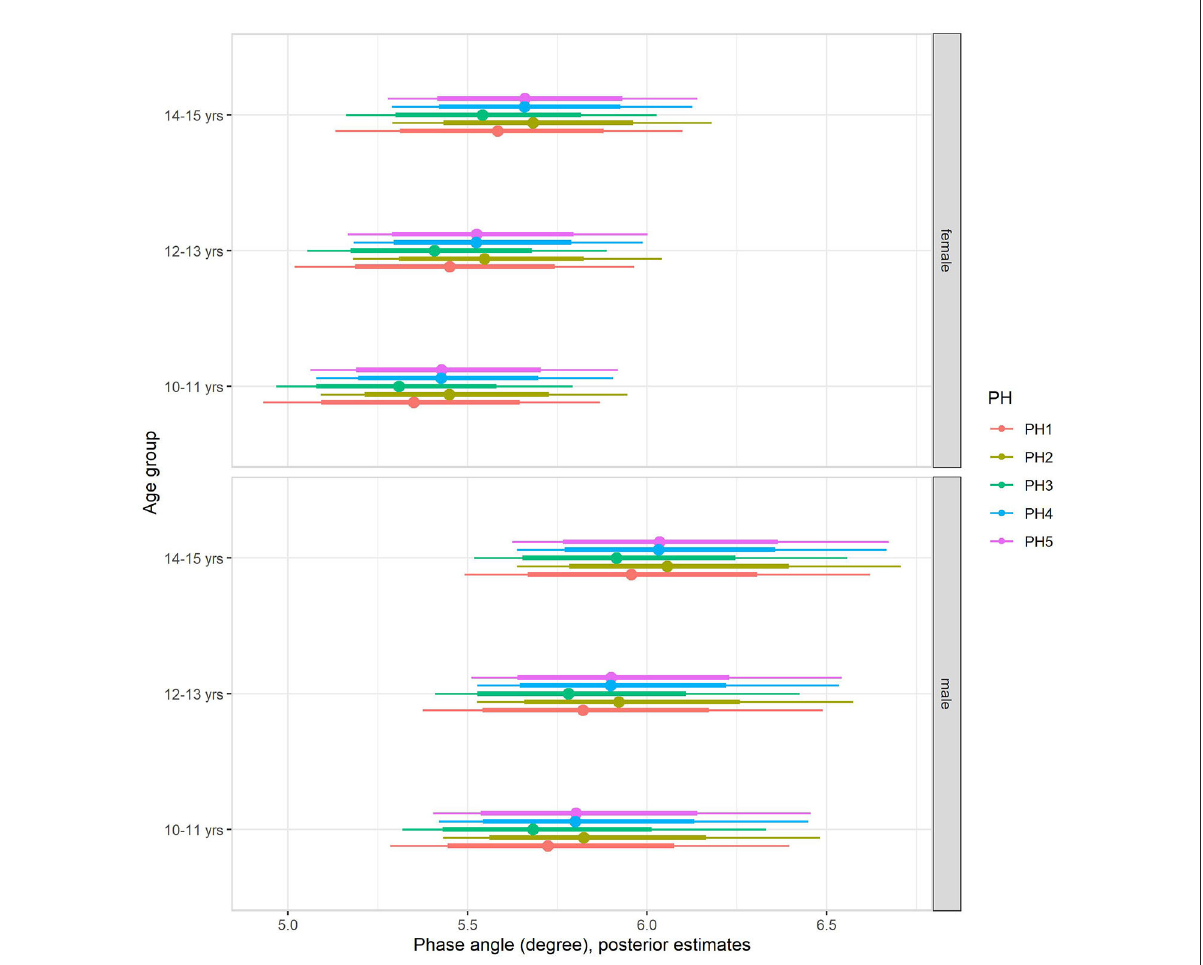
FIGURE2 Posterior estimations after adjusting for body mass (67 and 90% CIs) for the phase angle by age group and sexual maturity among Brazilian girls and